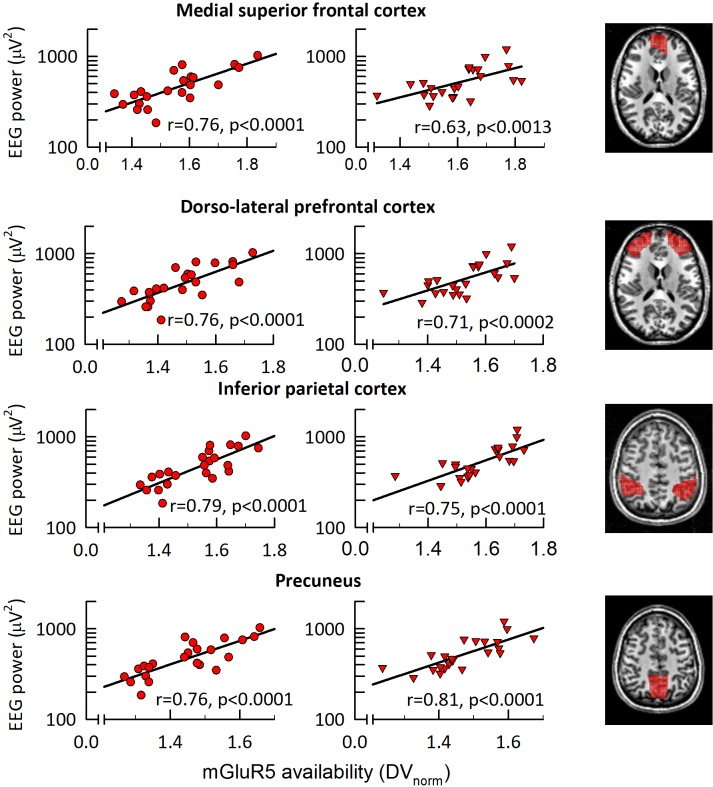
mGluR5 availability in fronto-parietal network correlates with EEG <1 Hz activity in NREM sleep.Association between the EEG slow oscillation activity (0.25–1.0 Hz) in the first NREM sleep episode of sleep control (left) and sleep deprivation (middle) conditions. Correlation plots: Significant (pall < 0.0015) Spearman rank correlation coefficients (r) between absolute EEG <1 Hz activity (C3M2 derivation) and regional mGluR5 availability in medial superior frontal cortex, dorso-lateral-prefrontal cortex, inferior parietal cortex, and precuneus. Right column: Axial slices illustrating the brain regions (red overlay) showing a significant association between EEG <1 Hz activity and mGluR5 availability. Z-coordinates according to the MNI brain atlas: medial superior frontal cortex, z = 16; dorso-lateral-prefrontal cortex, z = 16; inferior parietal cortex, z = 50; precuneus, z = 48.